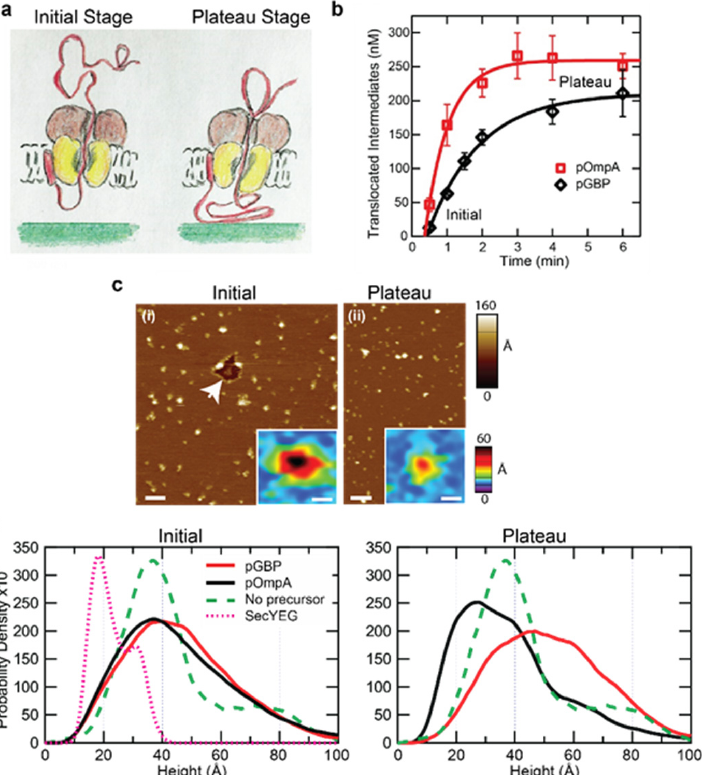
Figure 8. AFM study of Sec system at two stages of translocation. ( a ) Cartoon showing the main components: precursor (red) with an N-terminal signal sequence and a disulfide-stabilized loop, SecYEG (yellow), SecA (brown). Artwork credit: L.L. Randall. ( b ) Translocation activity of radiolabeled, oxidized pOmpA (red squares, n = 3) or oxidized pGBP (black circles, n = 3) assayed in vitro by protection from proteinase K. Error bars are SDs, and lines are fits to an exponential rise to maximum. ( c ) AFM images of Sec translocases with pOmpA at (i) the initial stage (30 s) of translocation, the arrow identifies a void in an otherwise continuous lipid bilayer, and (ii) at the plateau stage of activity (3 min). ( d , left panel) Height distributions of active Sec translocases at 30 s with either pOmpA (red curve, number of features included, N = 12,387) or pGBP (black curve, N = 10,063). Data for translocases SecYEG · SecA with no precursor (green dashed curve, N = 587) as well as SecYEG alone (magenta dotted curve, N = 1875) are shown for reference. After reaching the plateau stage, the ( d , right panel) height distributions of translocases engaged with pOmpA (red curve, N = 9565) or with pGBP (black curve, N = 6592) are shown. In all cases, translocation was halted by adding ADPAlF at the prescribed times. Note the vertical scale for SecYEG alone data was compressed two-fold in the height plots. Data are adapted from Ref. [15] .